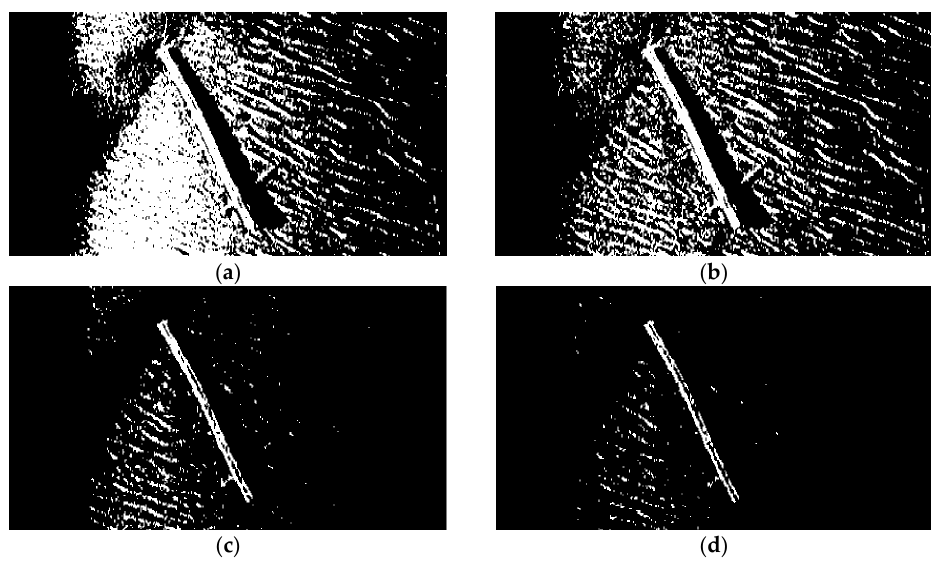
Figure 6. ( a ) Traditional Otsu TSM, Th = 0.1137; ( b ) Local TSM, Th = 0.0941; ( c ) Iterative TSM, Th = 0.2609; ( d ) Maximum entropy TSM, Th =